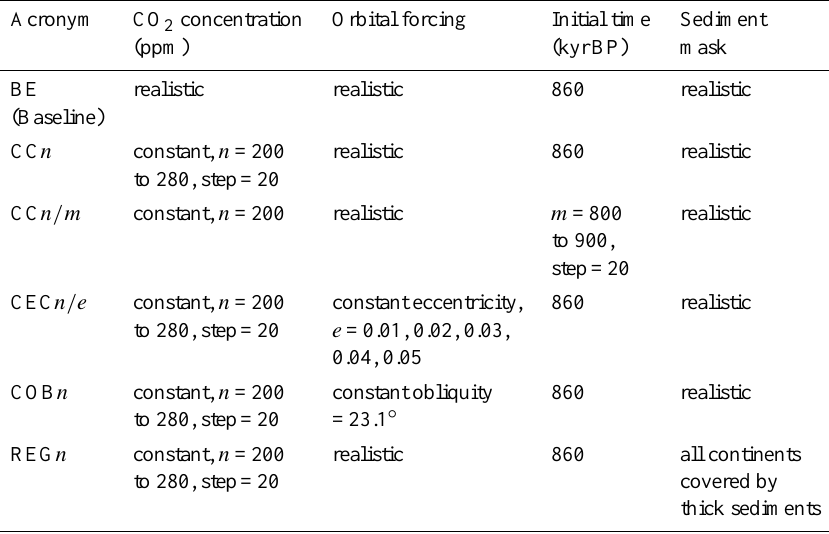
concentration. Figure 1c and d show simulated Greenland, east Antarctic and tropical SST in comparison with corre- sponding ice core records (NGRIP, 2004; Jouzel et al., 2007) and tropical SST stack (Herbert et al., 2010). The model cor- rectly simulates both the magnitude and temporal dynamics of temperature variations associated with glacial cycles. The Greenland temperature also contains strong millennial scale variability associated with simulated reorganizations of the Atlantic thermohaline circulation (Ganopolski et al., 2010). The magnitude of glacial-interglacial Greenland temperature changes is about 20 ◦ C, which is close to the estimates for the last glacial maximum. The variations in Antarctic tem- perature are roughly twice as small as those in